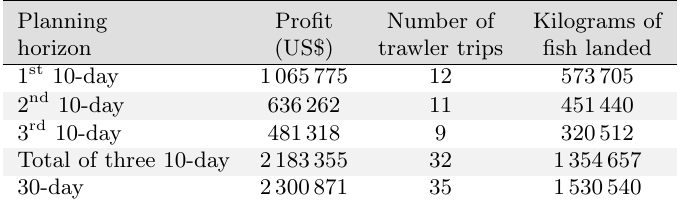
Table 2: Comparison between three 10-day horizons and a 30-day